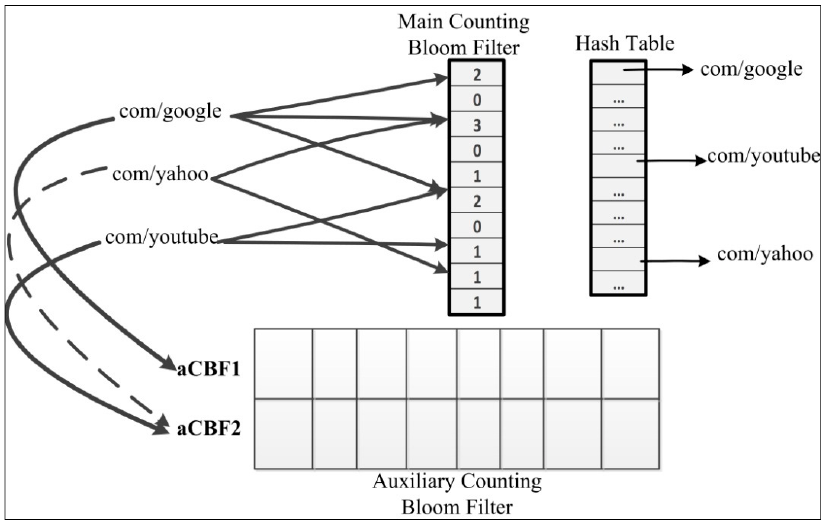
Figure6. BFAST data structures: CBF, auxiliary CBFs, and the HT. Figure 6. BFAST data structures: CBF, auxiliary CBFs, and the